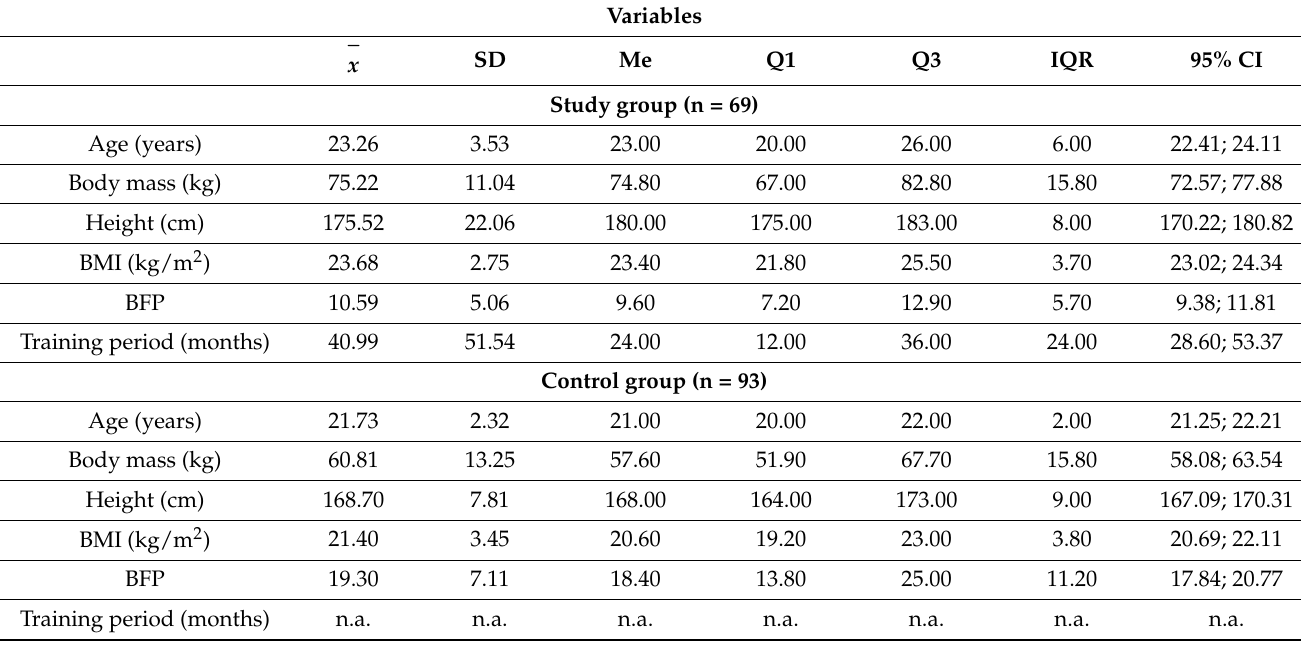
Table 1. Characteristics of the groups—descriptive statistics.